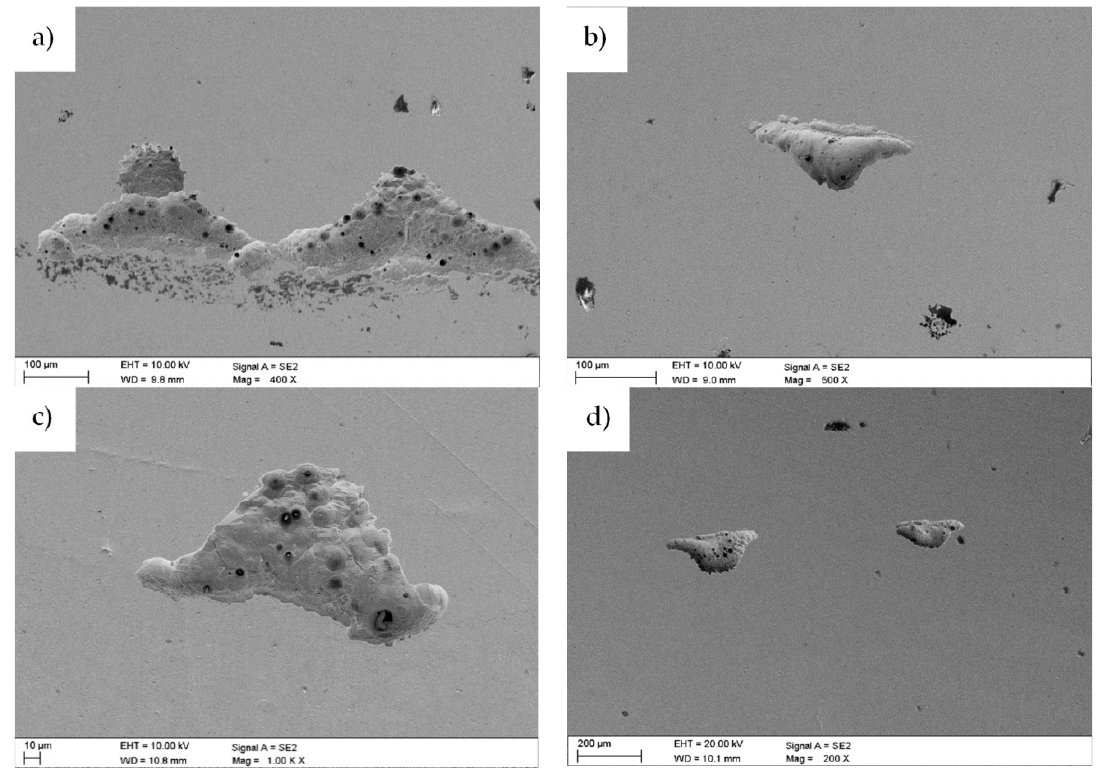
Figure 10. Surface morphology after an electrochemical examination of the sample: ( a ) uncoated; ( b ) with a ZnO coating deposited in 500 cycles; ( c ) 1000 cycles; and ( d ) 1500 cycles.